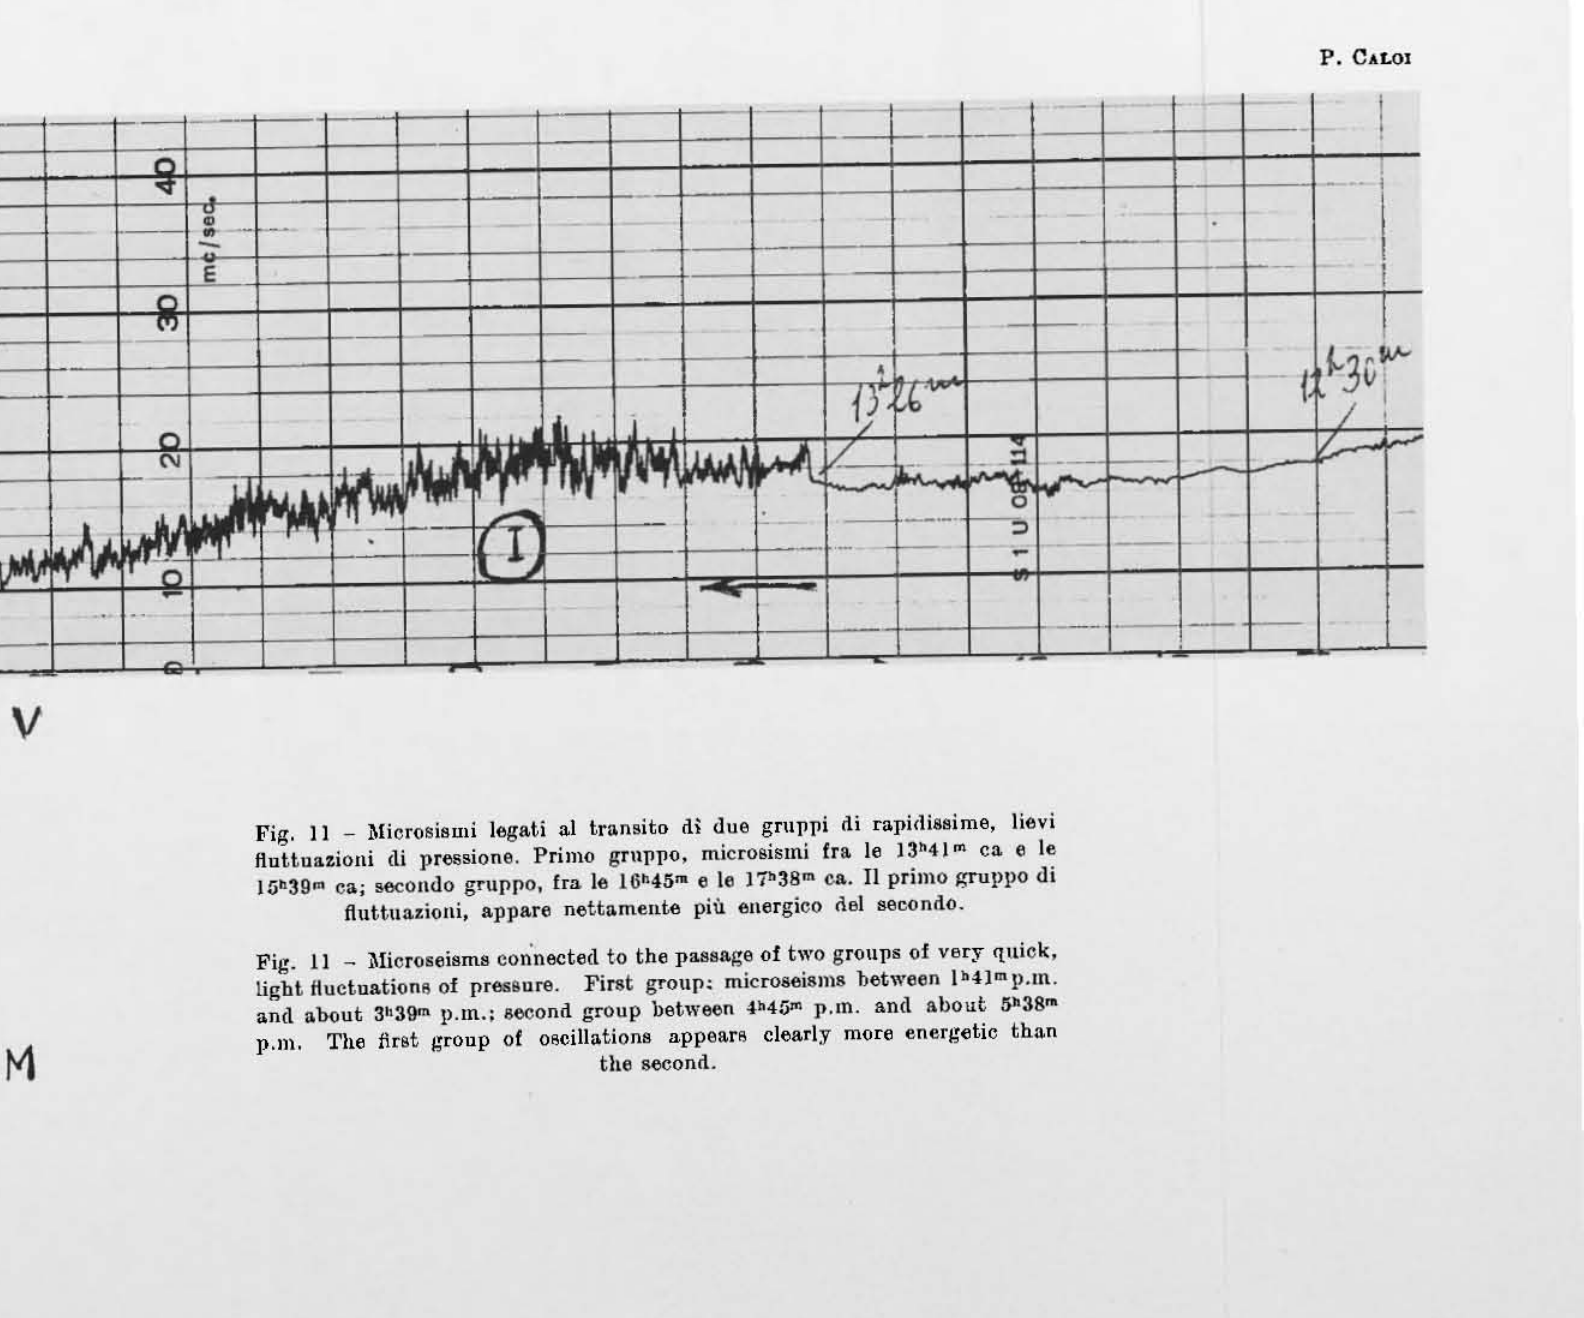
Fig. Il Microsismi legati al transito di due gruppi di rapidissime, lievi fluttuazioni (li prellsione. Primo gruppo, microsismi fra. le 13~41'" ca e le l:ib39m ca; secondo gnll"(,>o. Ira le IG h 4!)'" e le j 'jb38'" ca. Il primo gTuppo di ftllttlla:ioni, apparo nettamente più ellorgico dIII sec()nl\o. Fig. I l Microseism8 connecto(l to thc pa.88lLge 01 two groups 01 very quick. ligbt. ftud uationll 01 pres8ure. Fint geOllp; rnicroaeiSll\1I betw6en p'4)m p.m. and about 3h39'" p.m.: 8&Cond gl'Oup between "~45'" p.m. and abouL .5~38'" p.m. The first gronp 01 o8cillations appeara clcarl.v more energetic than the